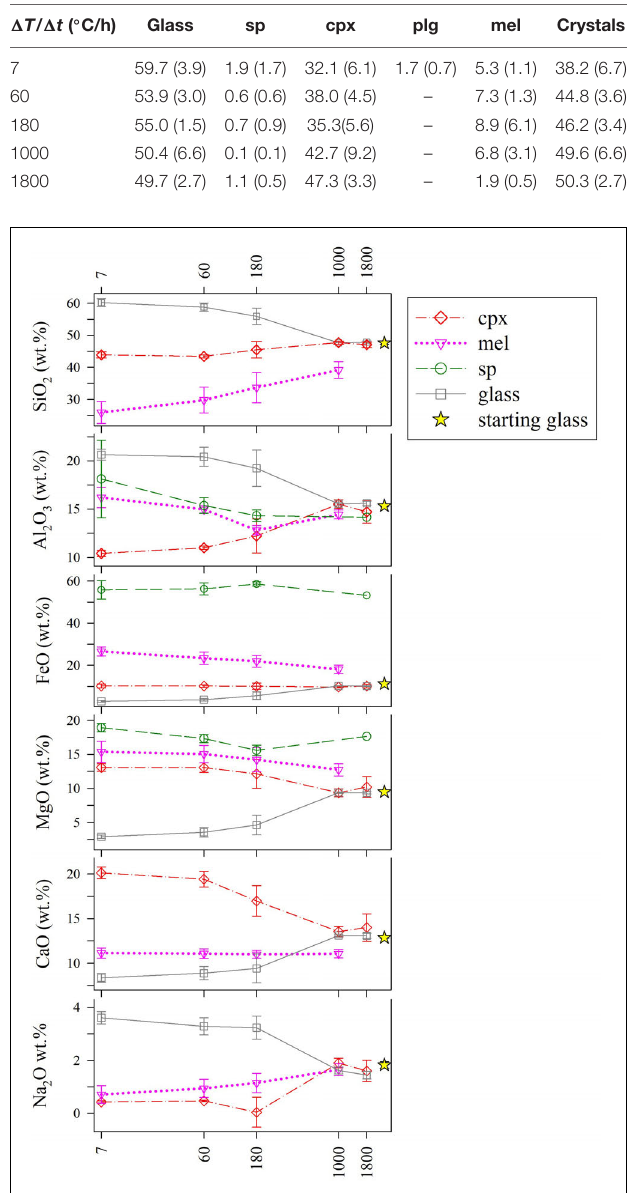
FIGURE 5 | Chemical variations of major oxides (wt.%) in cpx, mel, sp, and intra-crystalline glass as a function of (cid:49) T / (cid:49) t ( ◦ C/h). Average data are listed in Supplementary Table S1